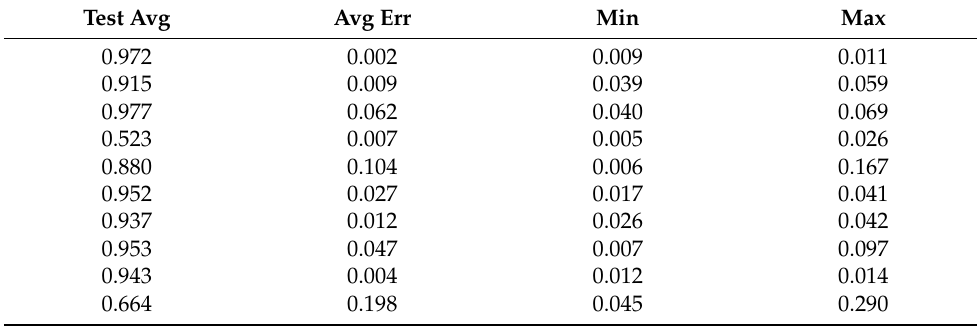
Table A177. Set 3, trials 11–20 data (actual PR value).